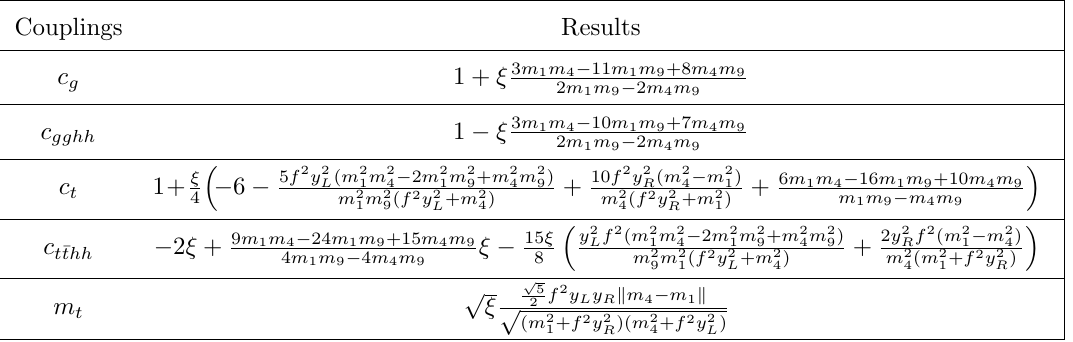
Table 5 . Higgs Couplings and top mass in MCHM of 14 + 14 Representation, which means t L and t R are both embedded in the 14 of SO(5).